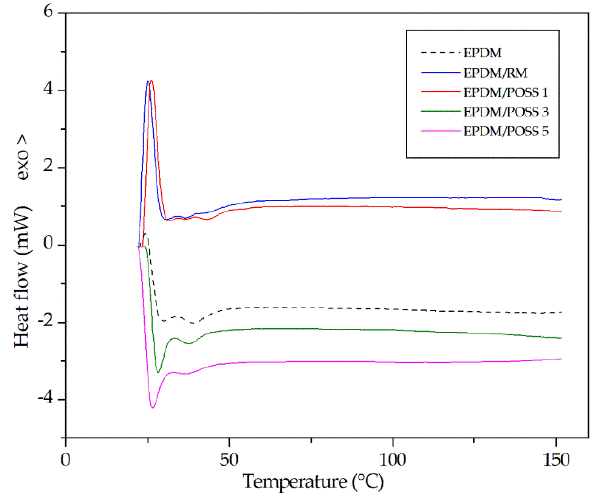
Figure 2. Differential scanning calorimetry curves for irradiated EPDM and prepared composites.